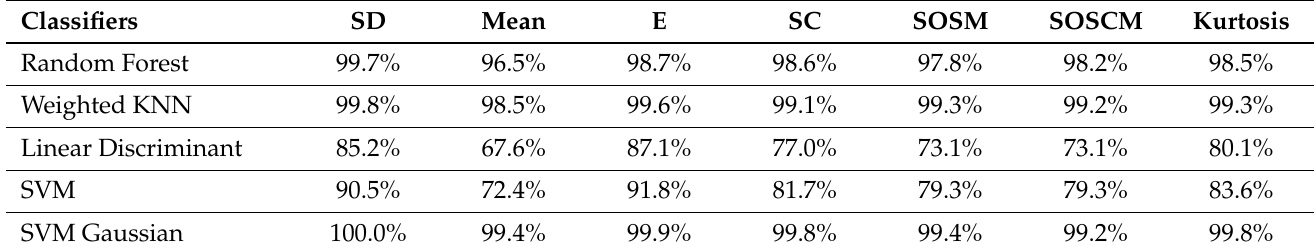
Table 8. Accuracy rate for every individual multi-link descriptor.